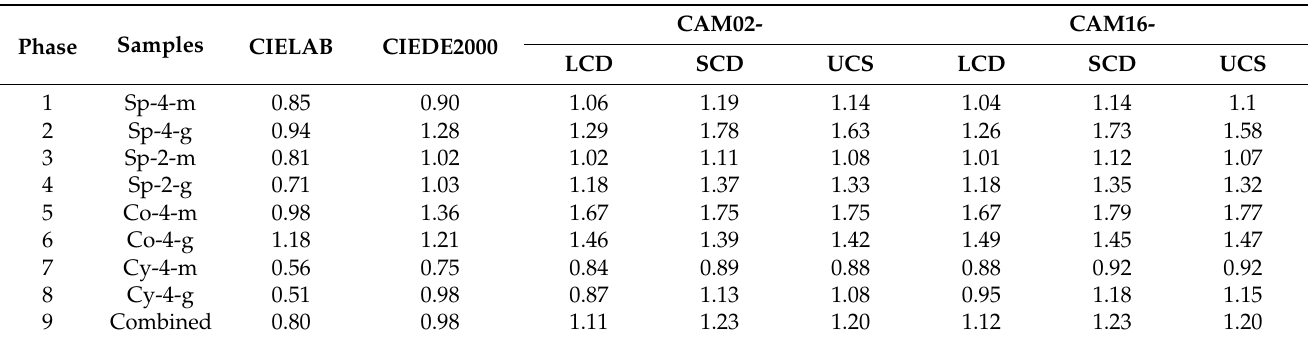
Table 5. Optimized values of the lightness parametric factor k L for eight color-difference formulas and nine phases (see Table 1) in the visual experiments in